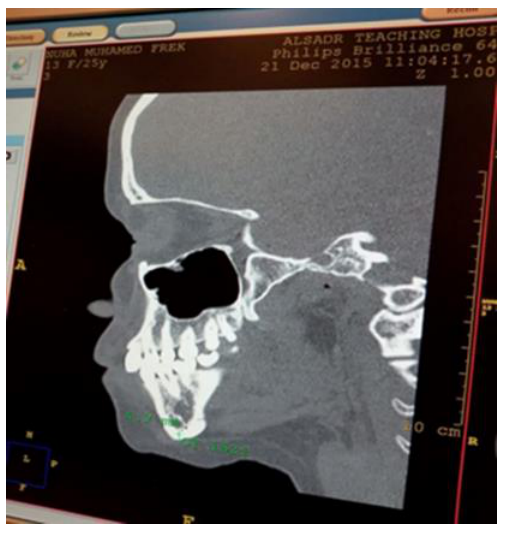
Fig:2 Radiologic image showing the measurement of cortical thickness and BMD in mental foramen area. Gonial angle : The angle of the